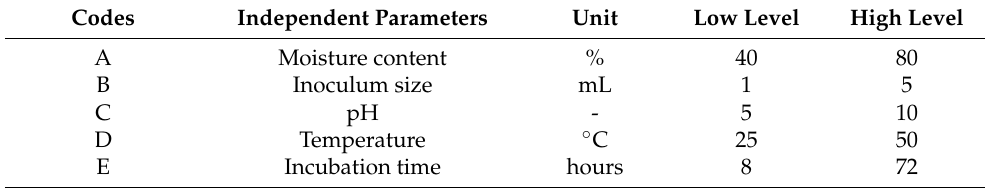
Table 2. Level of independent factors in the considered experiment.